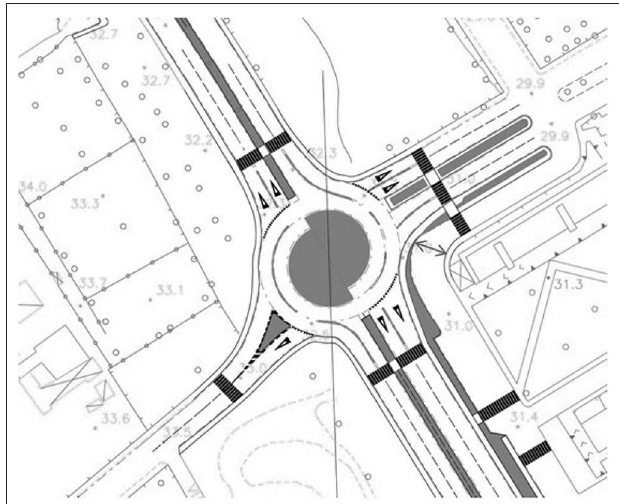
FIGURE 3 | Summary of traffic features of the examined roundabout 1 (Westbound approach). The origin-destination (O/D) matrix was surveyed on November 16, 2018 during 5-min sampling intervals (07:40–07:45). A stands for Northbound approach; B stands for Southbound approach; C stands for Eastbound approach; D stands for Westbound approach (see Figure 1 ); the heavy vehicles percentages observed in the field was made by single-unit trucks.